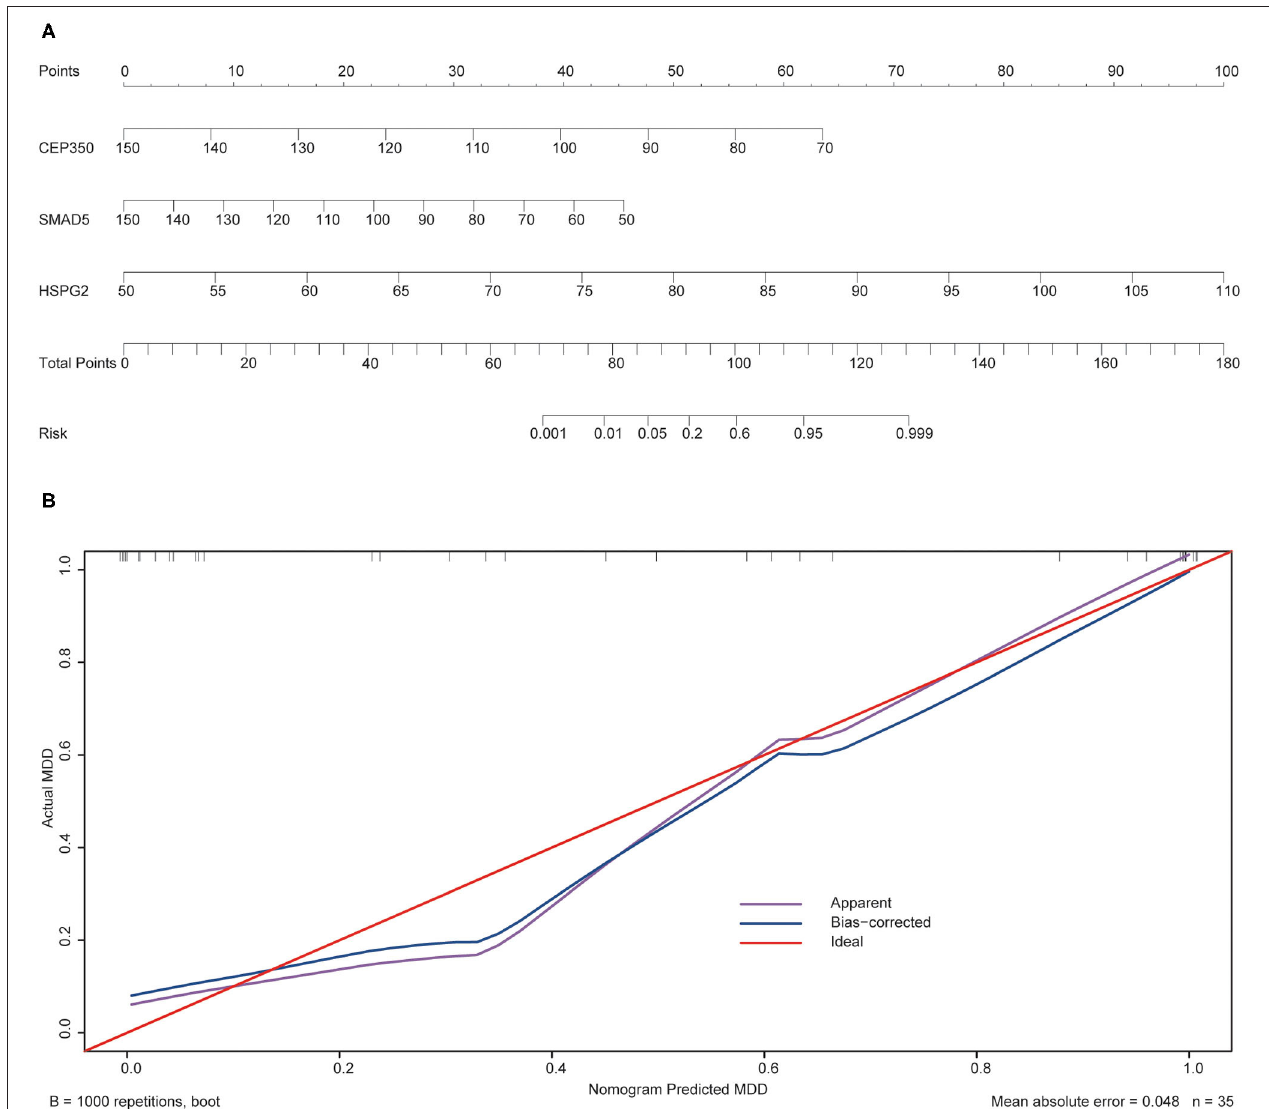
FIGURE 5 | The nomogram and calibration of combination of three hub genes (CEP350, SMAD5, HSPG2) in GSE53987. (A) Nomogram of three hub genes: the value in points line is matched with the value in lines of the genes based on their expression. Total points line refers to the sum of the matched points of these genes. And the risk range line is matched with the corresponding range in total points line; (B) Calibration of combination of the three genes: the apparent line is along with ideal line, and Hosmer-Lemeshow Test showed that there is no significant difference between ideal line and apparent